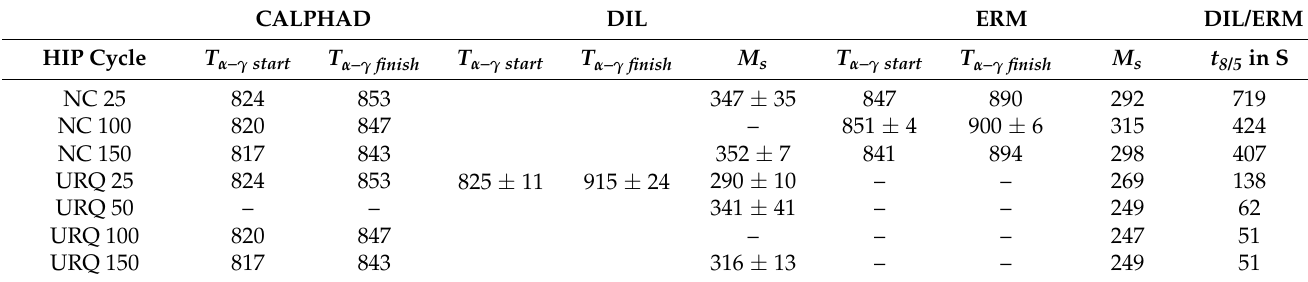
Table 3. Phase transformation temperatures as calculated using ThermoCalc software (pressure dependent calculations) as well as experimentally determined by means of dilatometry (DIL, ambient pressure) and electrical resistivity measurements (ERM, hydrostatic pressure) for varying cooling rates and pressures. CALPHAD DIL ERM